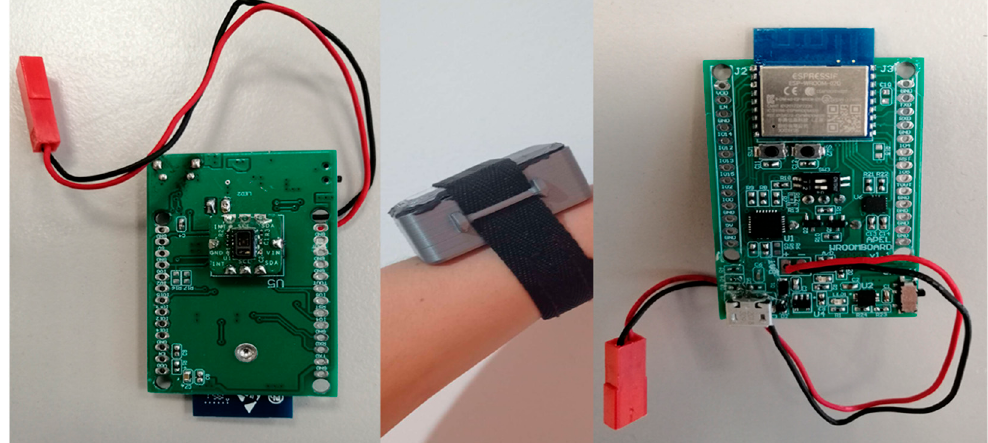
Figure 2. The proposed wearable device.